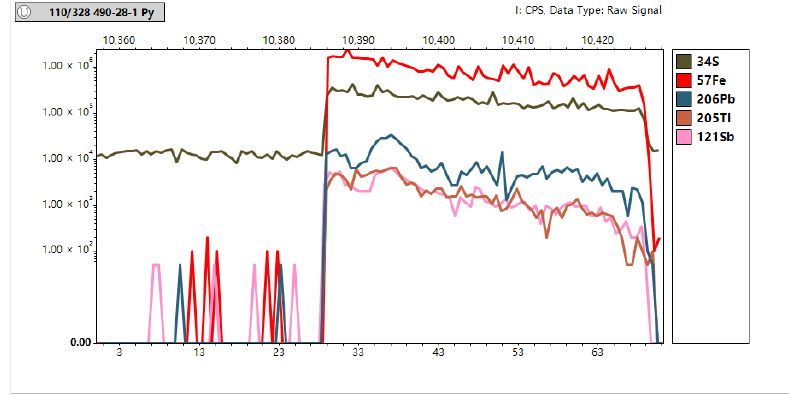
Figure 8. Time-resolved depth profiles of Pb, Tl, and Sb in Sample 490-28.